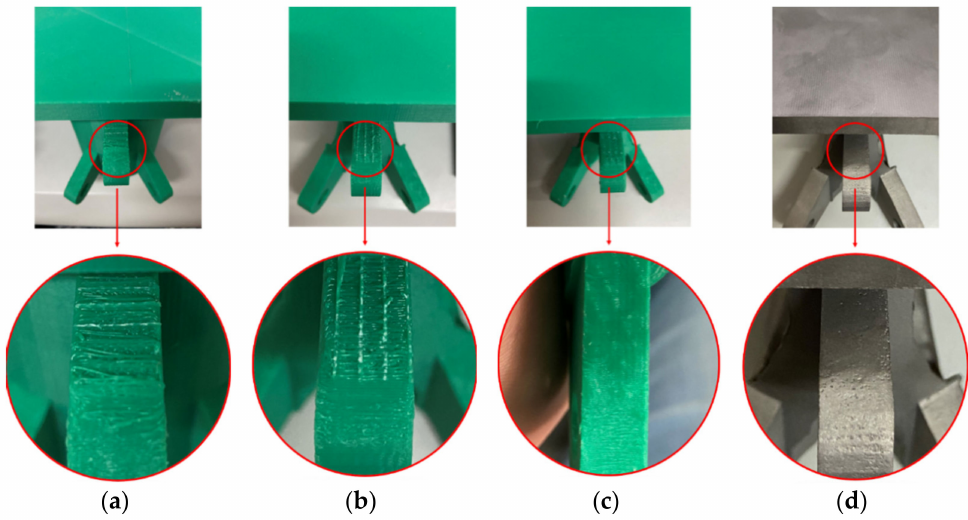
Figure 16. Influence of different support densities on the supporting surface: ( a ) 5% support;